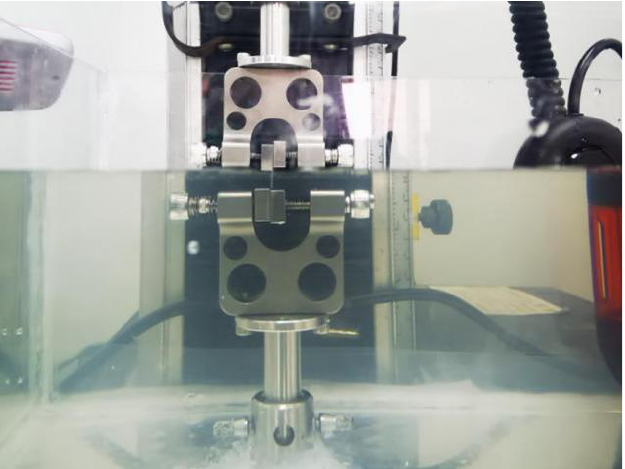
Figure 1. Evaluation of the elastic modulus of corneal strips was carried out by an Instron 5544 extensometer.